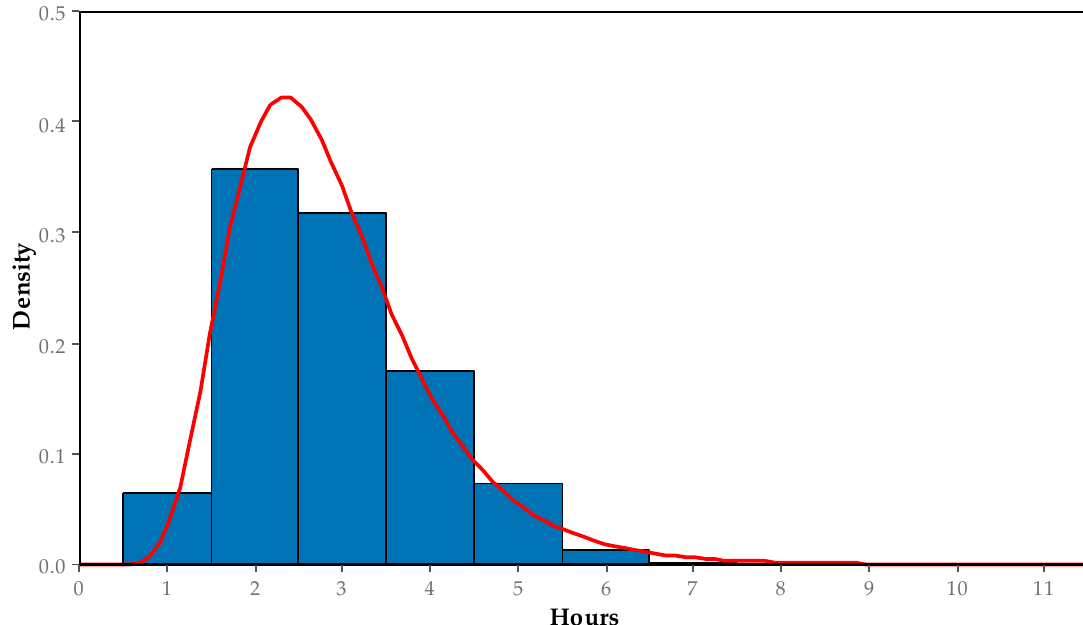
Figure 4. Histogram of the EV charge duration reported by the data analyzed and theoretical density in red (hours on the x-axis).